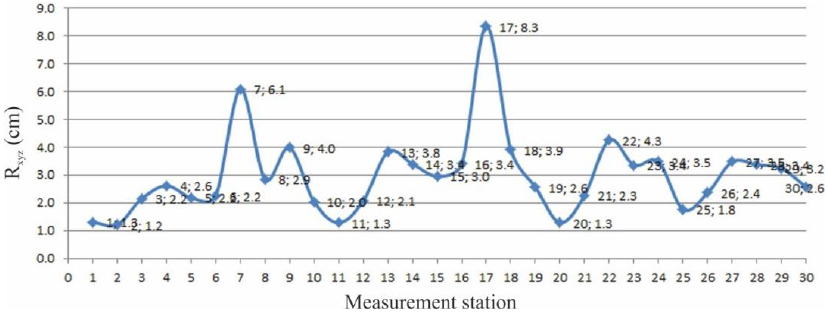
Figure 15. Resultant movement vector magnitudes (cm) calculated according to the measurements taken from the monitoring stations in the period of 24 February 2013 and 29 May 2013.